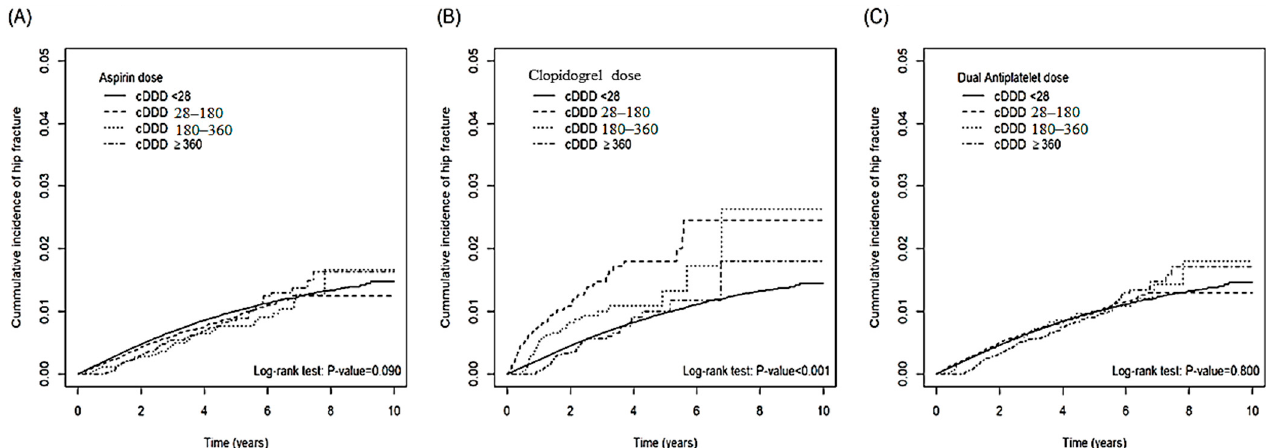
Figure 1. The cumulative incidence of hip fracture among patients with different cumulative defined daily doses (cDDDs) of aspirin ( A ), clopidogrel ( B ), and dual anti-platelet agents ( C ).